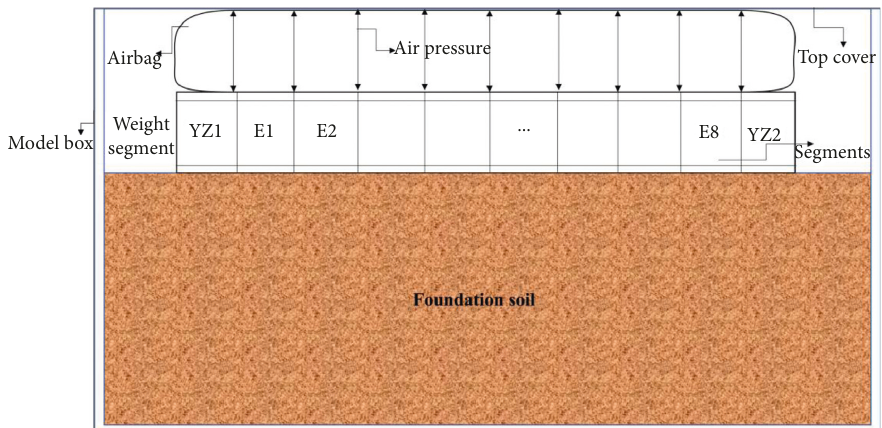
Figure 10: The schematic diagram of the loading device.